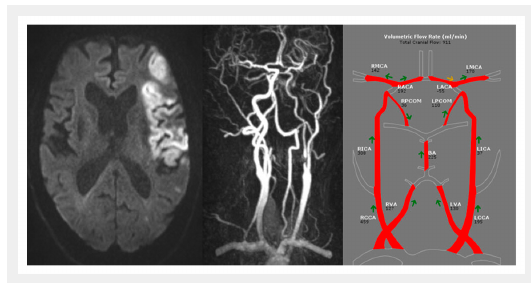
Figure 5 Illustrative case of a 61 year male patient with ischaemic stroke in the left MCA territory due to high grade stenosis of the left ICA with consecutive reversal of flow in the left ACA. BA = basilar artery; LACA = left anterior cerebral artery; LCCA = left common carotid artery; LICA = left internal carotid artery; LMCA = left middle cerebral artery; LPCA = left posterior cerebral artery; LVA = left vertebral artery; RACA = right anterior cerebral artery; RCCA = right common carotid artery; RICA = right internal carotid artery; RMCA = right middle cerebral artery; RPCA = right posterior cerebral artery; RVA = right vertebral